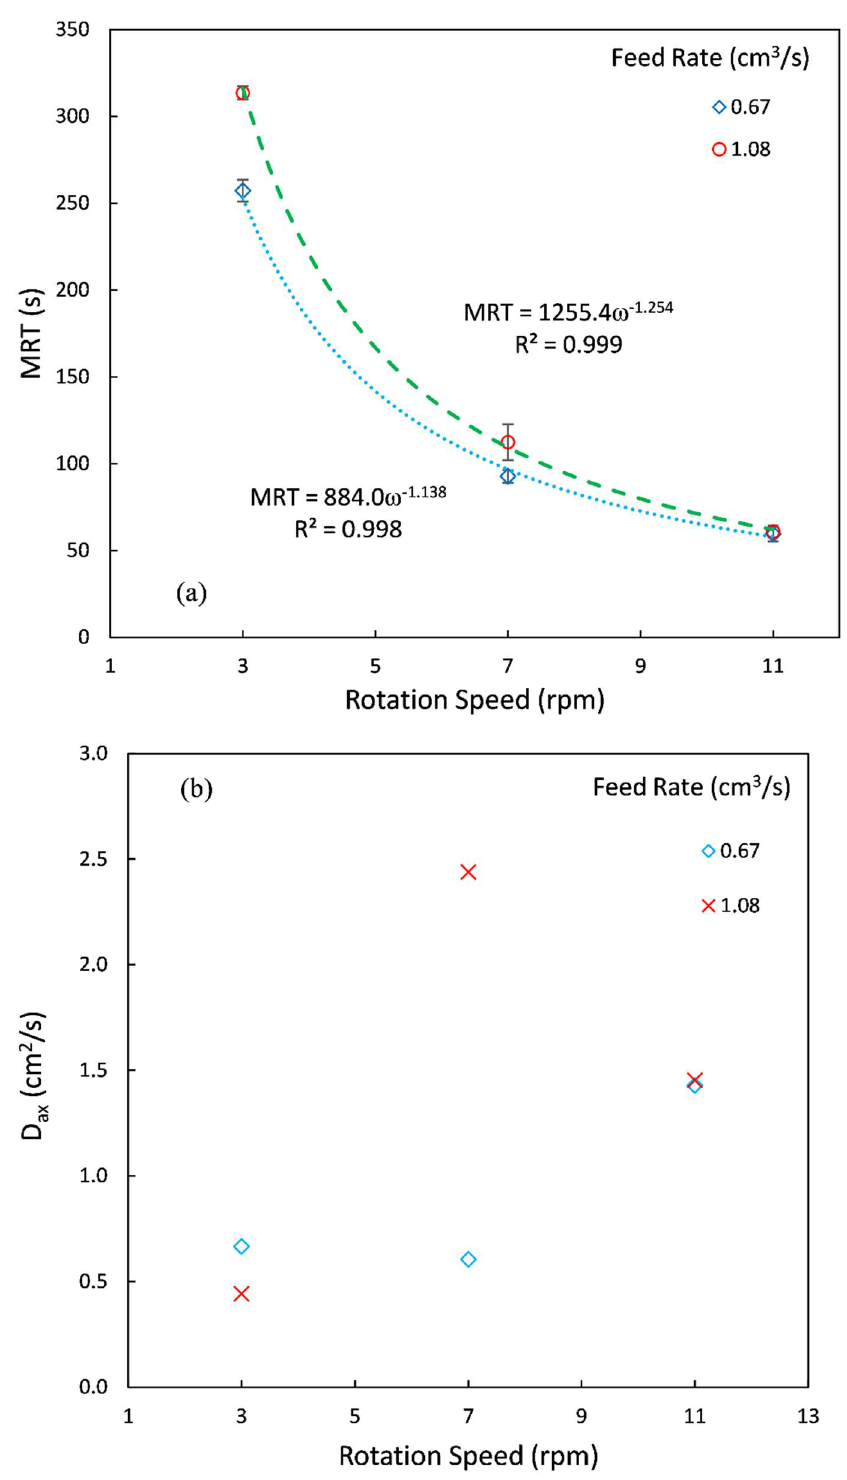
Figure 8 . Effect of feed rate on ( a ) MRT ( b ) axial dispersion coefficient at 3° for 6 mm cube. Figure 8. Effect of feed rate on ( a ) MRT ( b ) axial dispersion coefficient at 3 ◦ for 6 mm